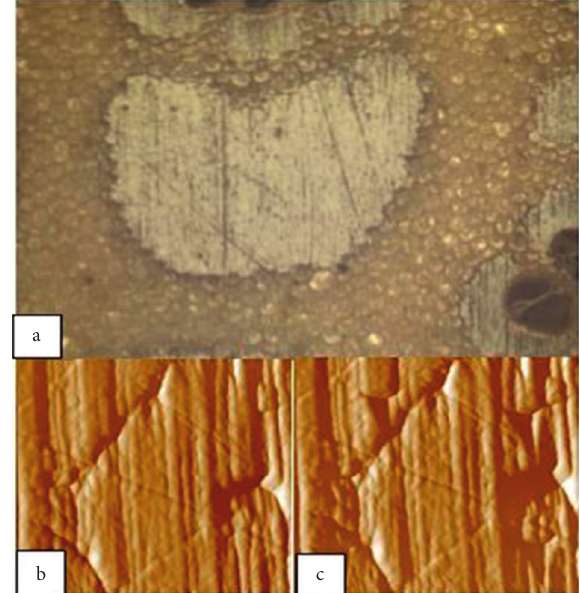
Figure 12: Fibre cell wall from (a) microscopic level, (b) AFM before indentation, and (c) AFM after indentation.